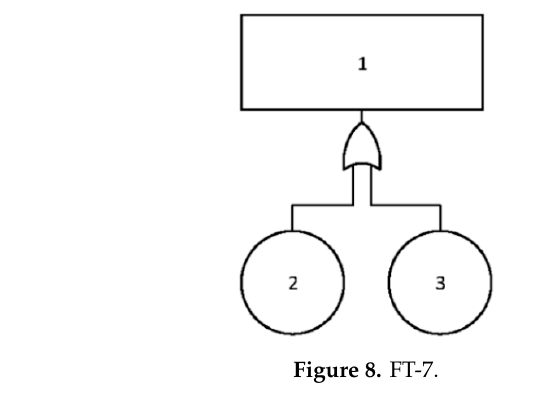
Figure 7. Simplified of FT-6.